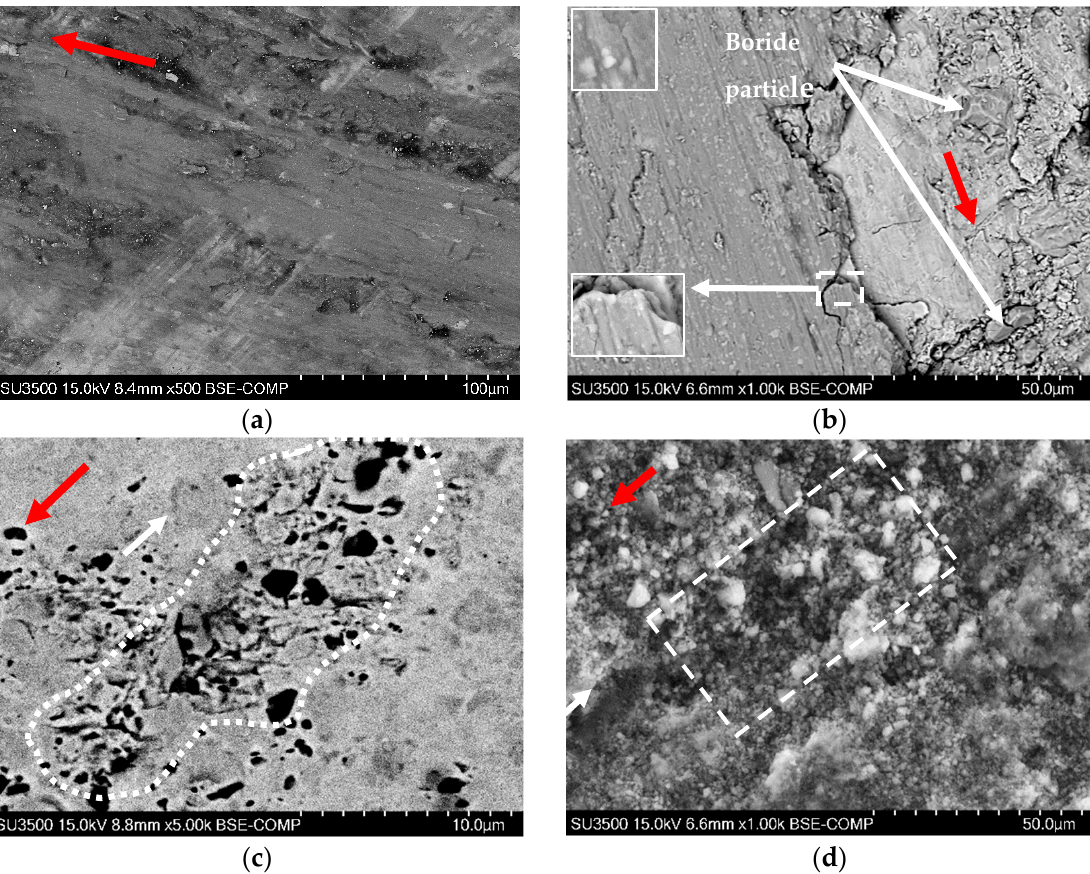
Figure 11. The micrographs of the friction surface of samples: ( a ) general surface, 4 MPa; ( b ) the microstructure of the secondary contact plateaus and apexes of vertically oriented boride grains (Figure 9a), 10 MPa, magnification of inserts, 5000; ( c ) top view of the rosette carbides on the friction surface, 7 MPa; and ( d ) wear debris on the friction surface, 15 MPa. Red arrows show the friction direction